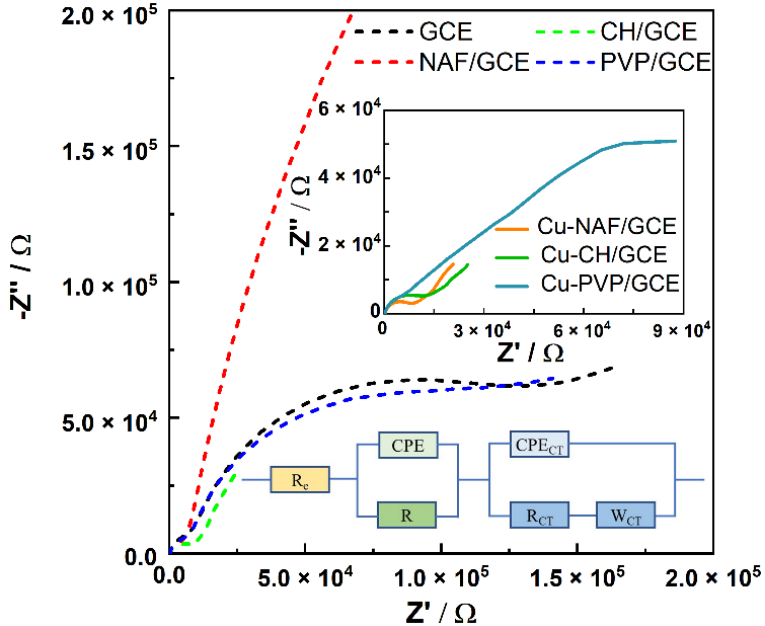
Figure 3. Impedance spectra in the Nyquist configuration for bare and modified GCEs in the 0.1 M